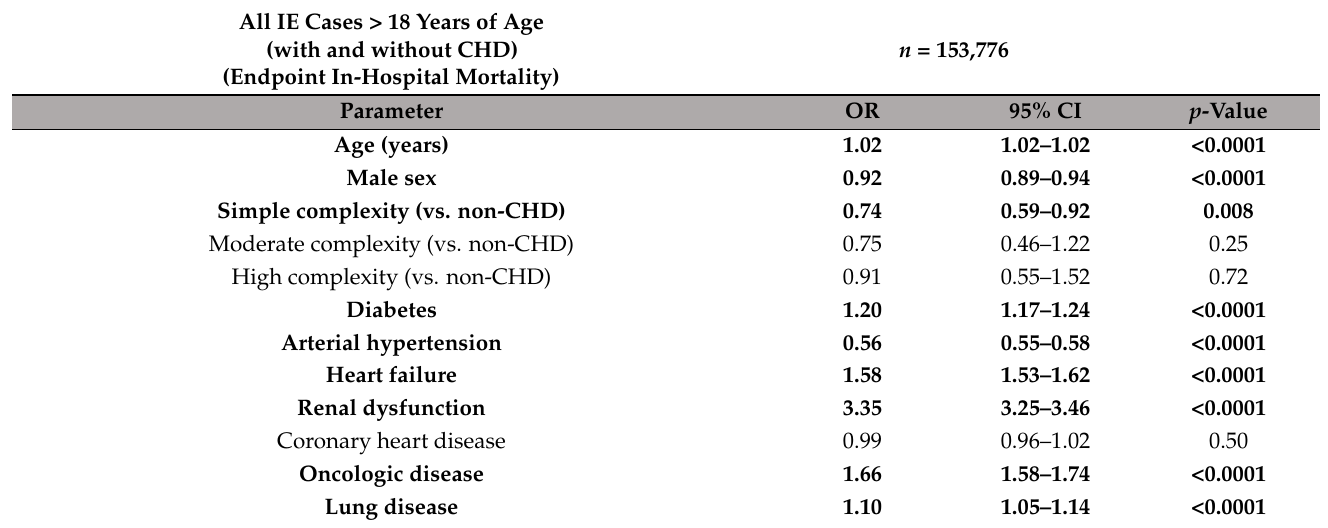
Table 2. Association between age, sex, disease complexity and co-morbidities, and death specifically in all adult patients with infective endocarditis. IE = infective endocarditis; CHD = congenital heart disease; CI = confidence interval; OR = odds ratio. Significant variables are in bold.